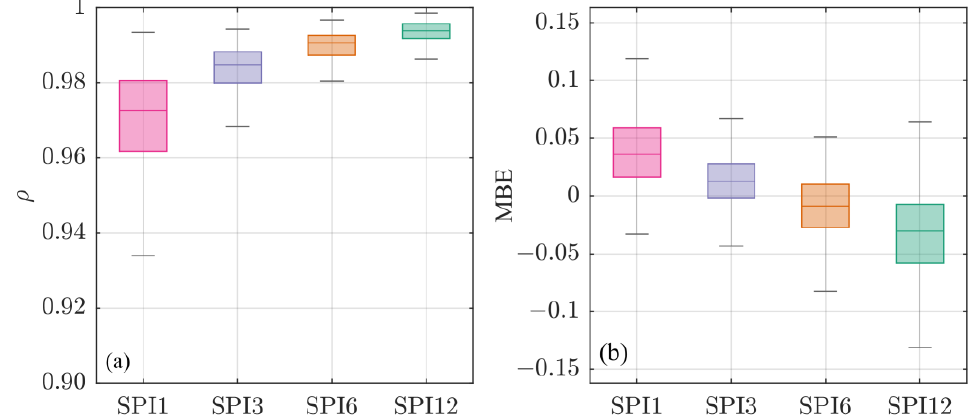
Figure 2. Box plots representing the Pearson correlation coefficient ( a ) and the Mean Bias Error ( b ) between the SPI values estimated with the SA and the BFA for each time scale.